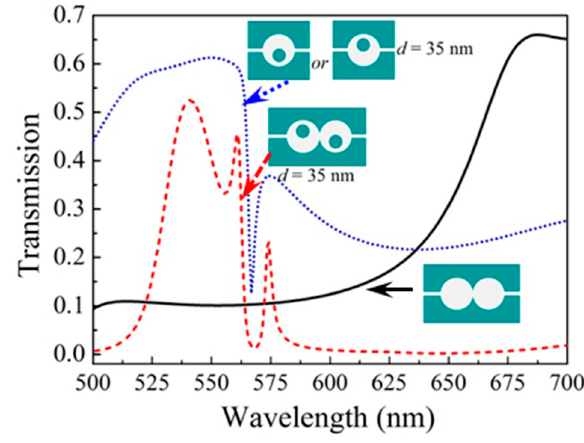
Figure 4. Transmissions for three kinds of different structures.